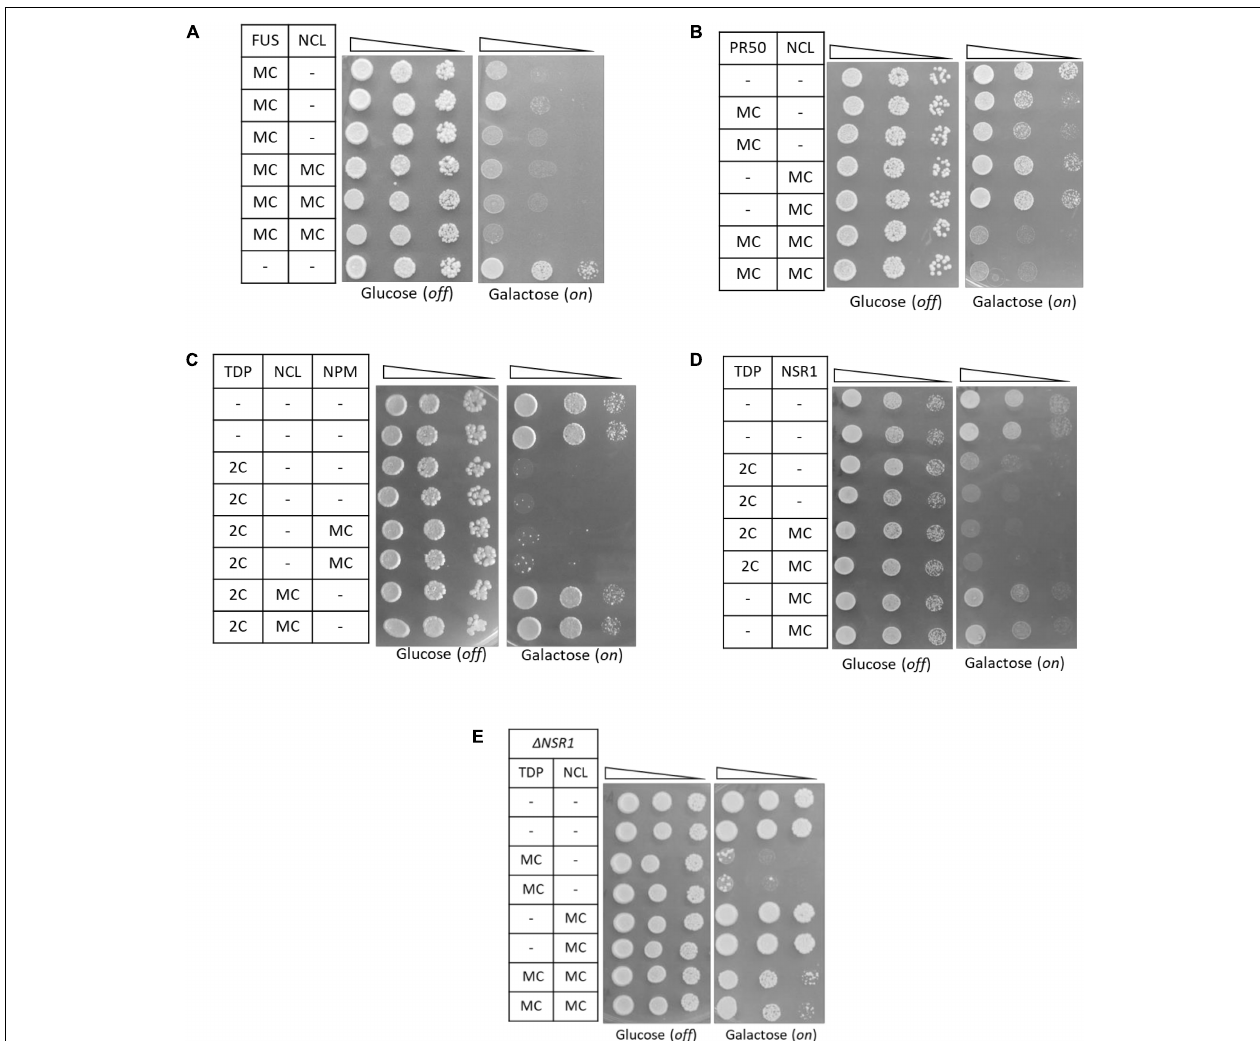
FIGURE 5 | The functional relationship between TDP-43 and NCL in yeast is highly specific. (A,B) Yeast CENPK cells were co-transformed with a MC plasmid coding for FUS (A) , or the C9orf72-PR50 repeats (B) , together with the MC plasmid for NCL, or with empty vectors as negative controls (–). Yeast cells (OD 600 = 1) of each strain were serially diluted (10-fold) and spotted onto either inducing medium plates (galactose, FUS/PR50/NCL on), or repressing condition as control (glucose, FUS/PR50/NCL off), and incubated at 30 ◦ C for 3 days. Data are representative of three experiments yielding comparable results. (C,D) Spotting assay [as in panels (A,B) ] of yeast strains carrying two genomic copies of TDP-43 transgene (TDP 2C), or unmodified CENPK (–), both transformed with MC plasmids encoding either NCL, its functional partner nucleophosmin (NPM), its putative ortholog in yeast (NSR1) or the empty vector as control (–). (E) Spotting assay (as above) of the yeast CENPK strain carrying the deletion of the NSR1 gene ( (cid:49) NSR1 ), co-transformed with multi-copy plasmid (MC) overexpressing either TDP-43 (TDP), NCL, or a control empty vector (–). In all panels data are representative of three experiments yielding comparable